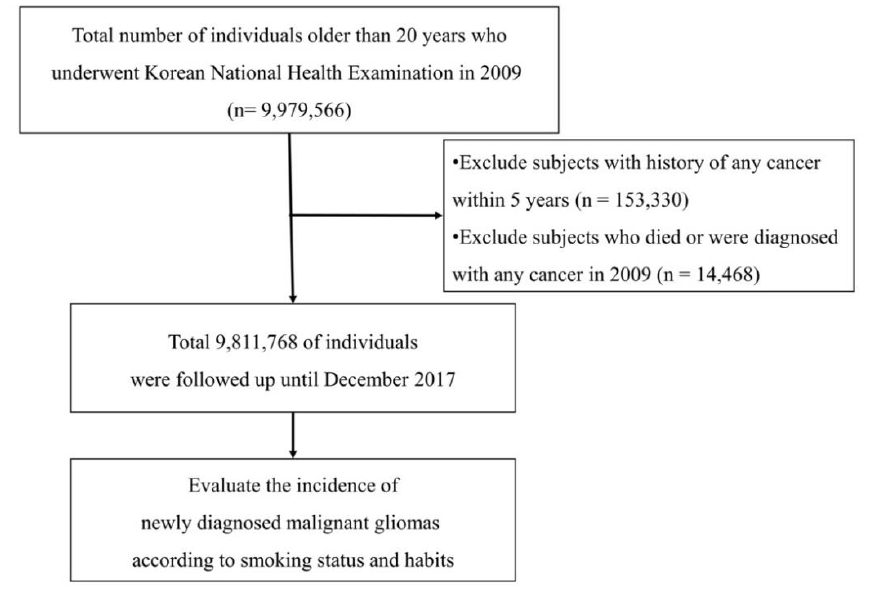
Figure 2. Flow of the study design.